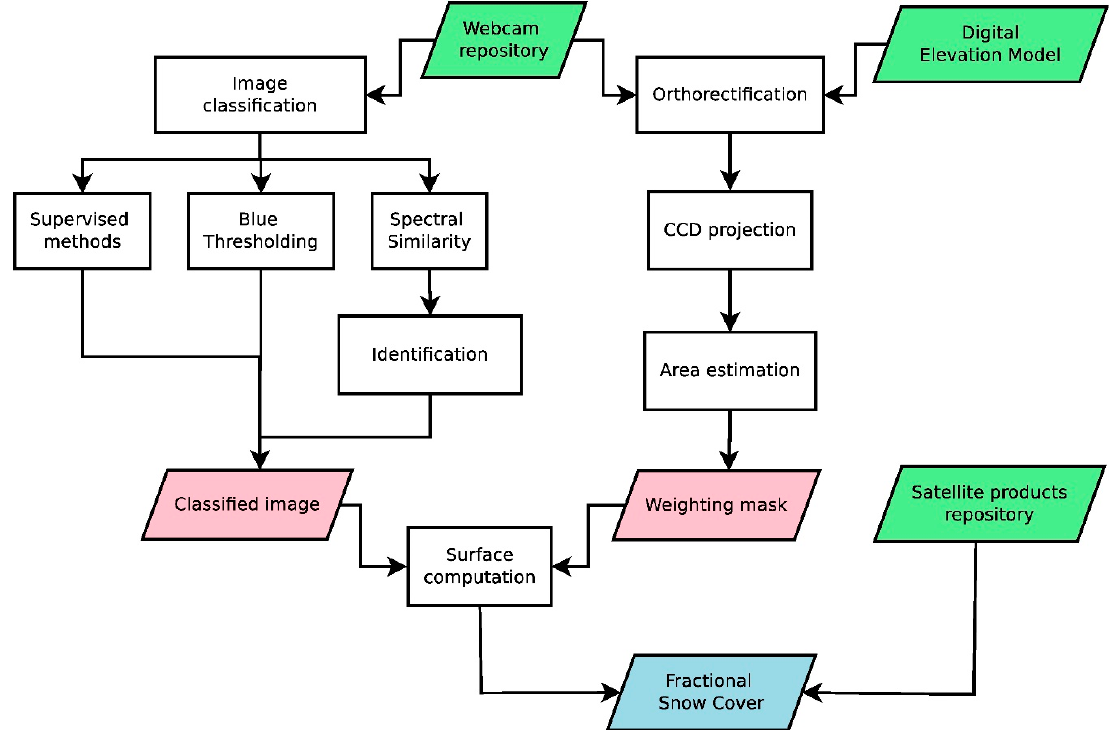
Figure 1. Description of the workflow followed in the manuscript. While the green boxes represent the considered data sources, the other colored boxes constitute the final products obtained by the different procedures required for the estimation of the Fractional Snow Cover.